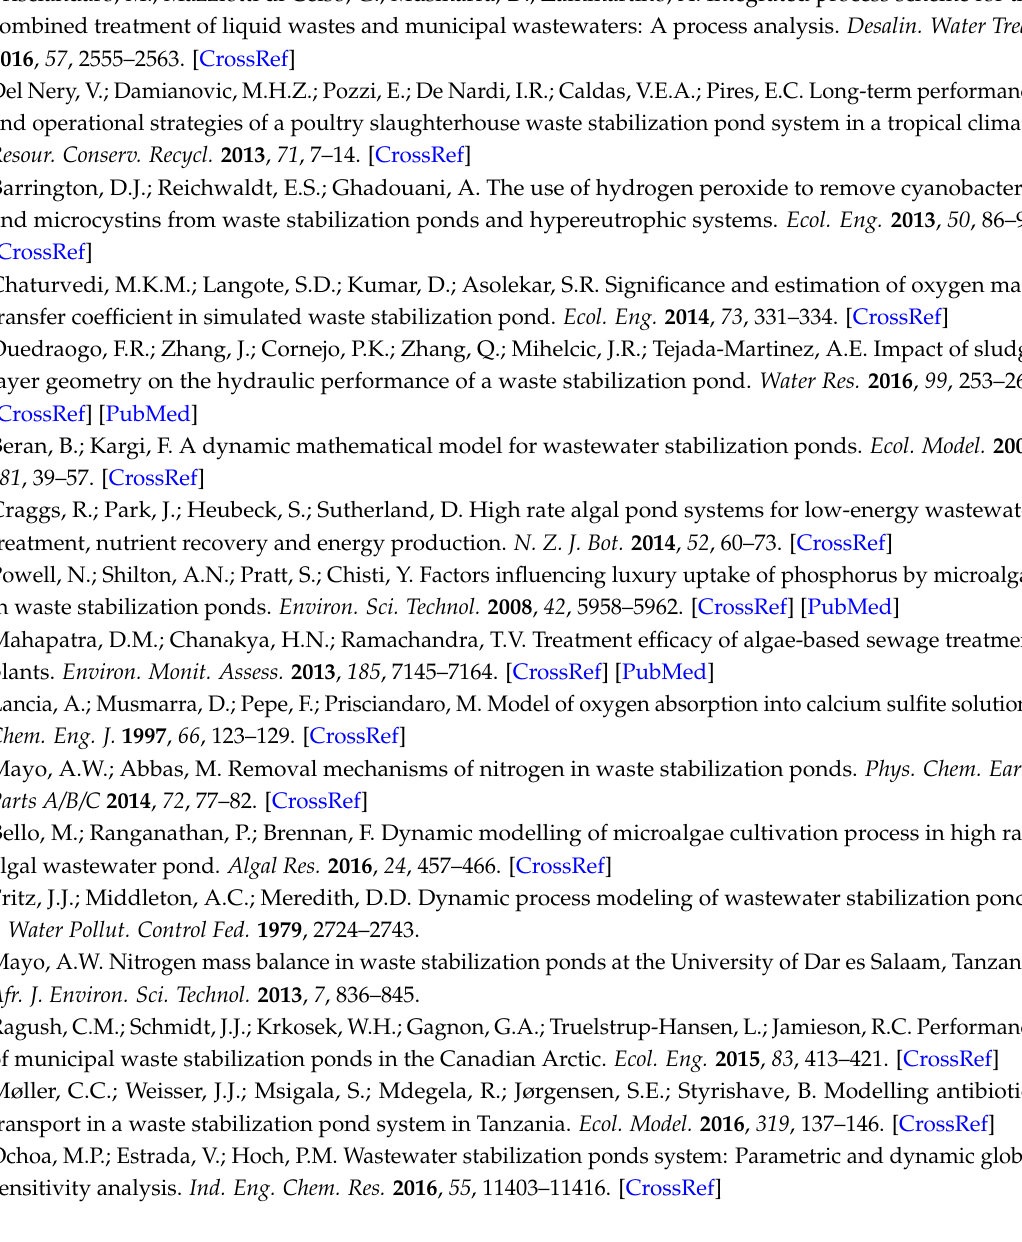
Figure S1: Collinearity index for selected 9 parameters, Table S1: List of R-FME functions used, Table S2: One-way analysis of variance (ANOVA) for ON-N. Similar results for NH 3 -N and NO 3 -N are not